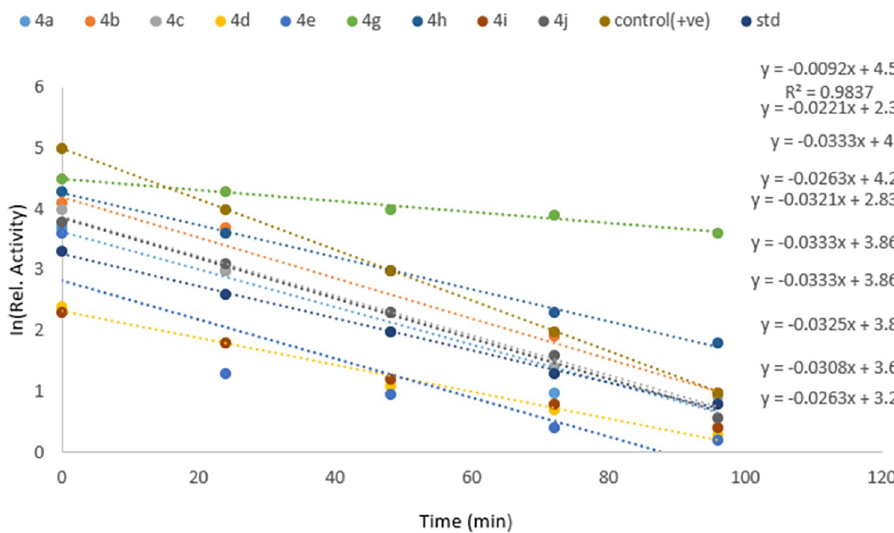
Fig 7. Determination of half-life of ciprofloxacin derivatives 4a-j.